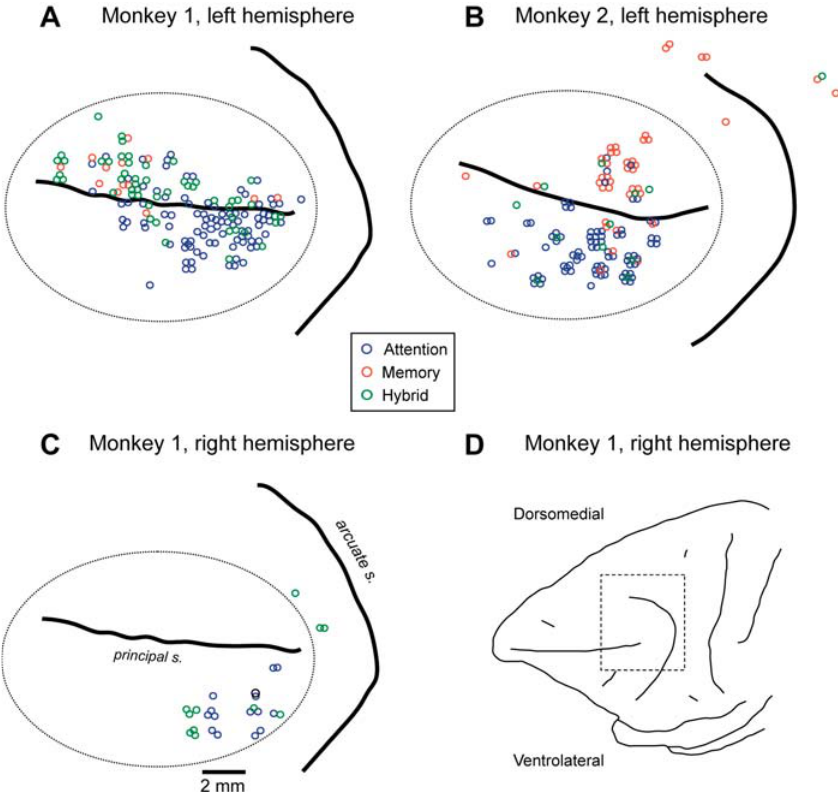
Figure 4. Surface Projections Showing the Location of Neurons in Each Class All hemispheres are displayed so that rostral is to the left and dorsomedial is up. Reconstructed surface projections of the left hemispheres of monkey 1 (A) and monkey 2 (B). (C) Surface projection of the (inverted) right hemisphere of mon- key 1. (D) A lateral view of the hemi- sphere shown in (C), with the region included in (C) approximated by the dashed box. The dotted ellipse encloses the cells deemed to lie inside the PFdl by histological analysis, but does not corre- spond to the cytoarchitectonic bounda- ries of area